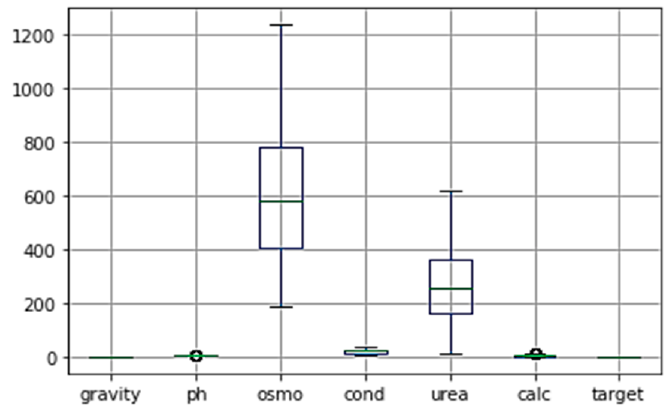
Figure 5. Box plot. Target 0 represents the absence of kidney stones and target 1 represents the presence of kidney stones, which have been found by using the collected dataset and by analyzing the features of the data. The histogram that represents the presence and absence of kidney stones is shown in Figure 6.